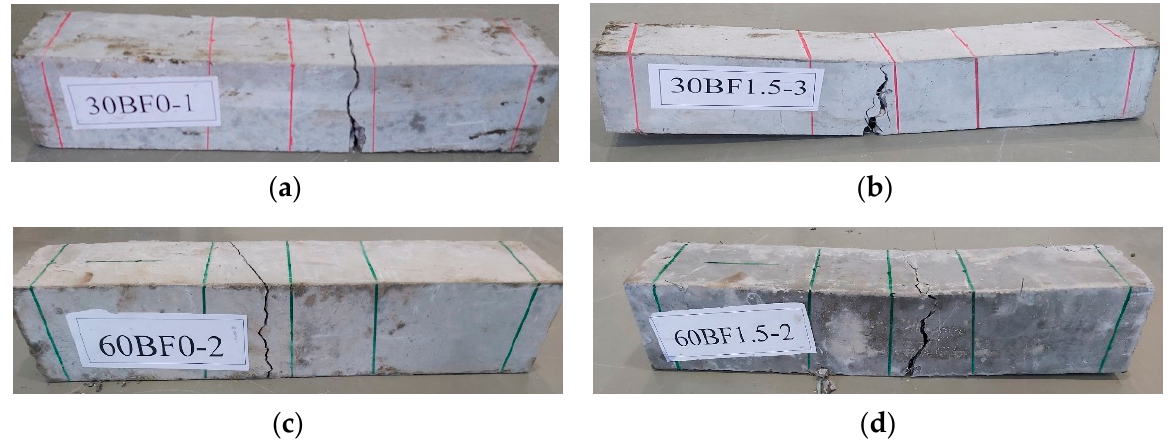
Figure 14. Failure mode of NSC and HSC prismatic specimens: ( a ) NSC-BMF0.0; ( b ) NSC-BMF1.5; ( c ) HSC-BMF0.0; ( d ) HSC-BMF1.5.